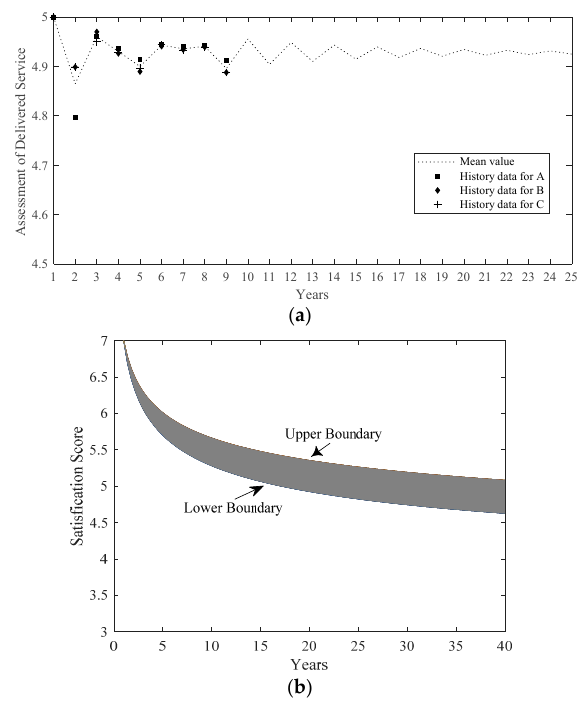
Figure 7. ( a ) Forecasting profile for A ( t ) of PPP schools at t = 25. ( b ) Forecasting profile for P ( t ) of PPP